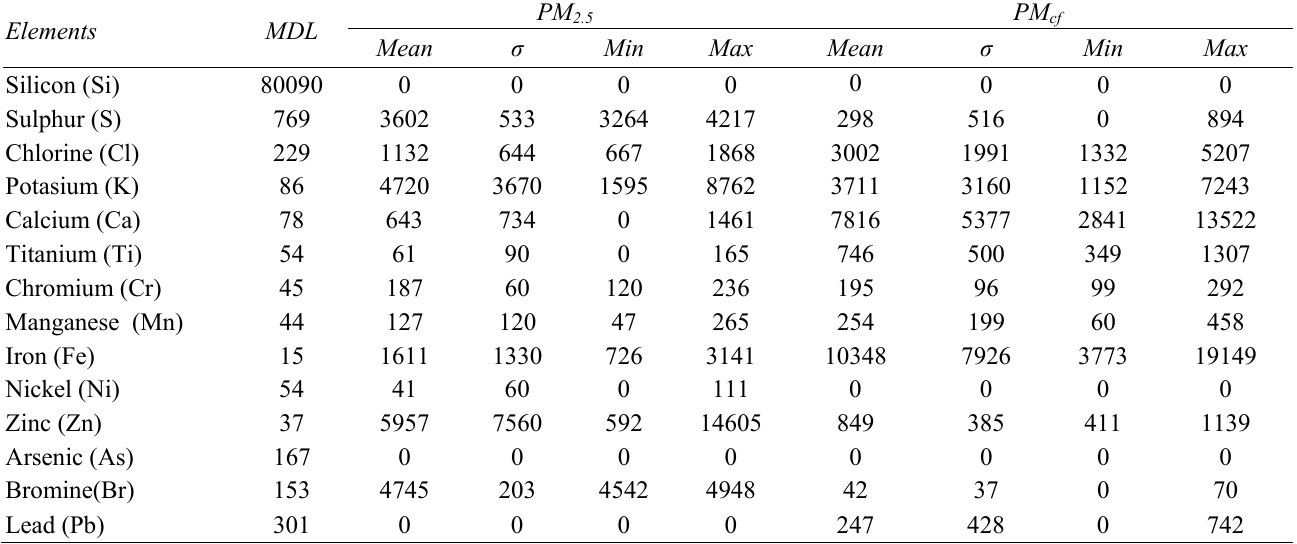
Table 3b : Arithmetic mean concentrations (ng/m 3 ) and standard deviation ( σ ) of various elements detected in aerosol samples from Morinda. MDL stands for minimum detection limit of the PIXE set up at Bhubaneshwar for the aerosol samples in (ng/m 3 ). To calculate the arithmetic mean the concentrations of the elements in the samples where these were below detection limits were taken to be